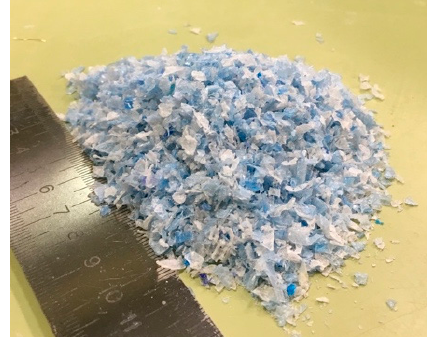
Figure 1. Photo of the shredded PET particles.